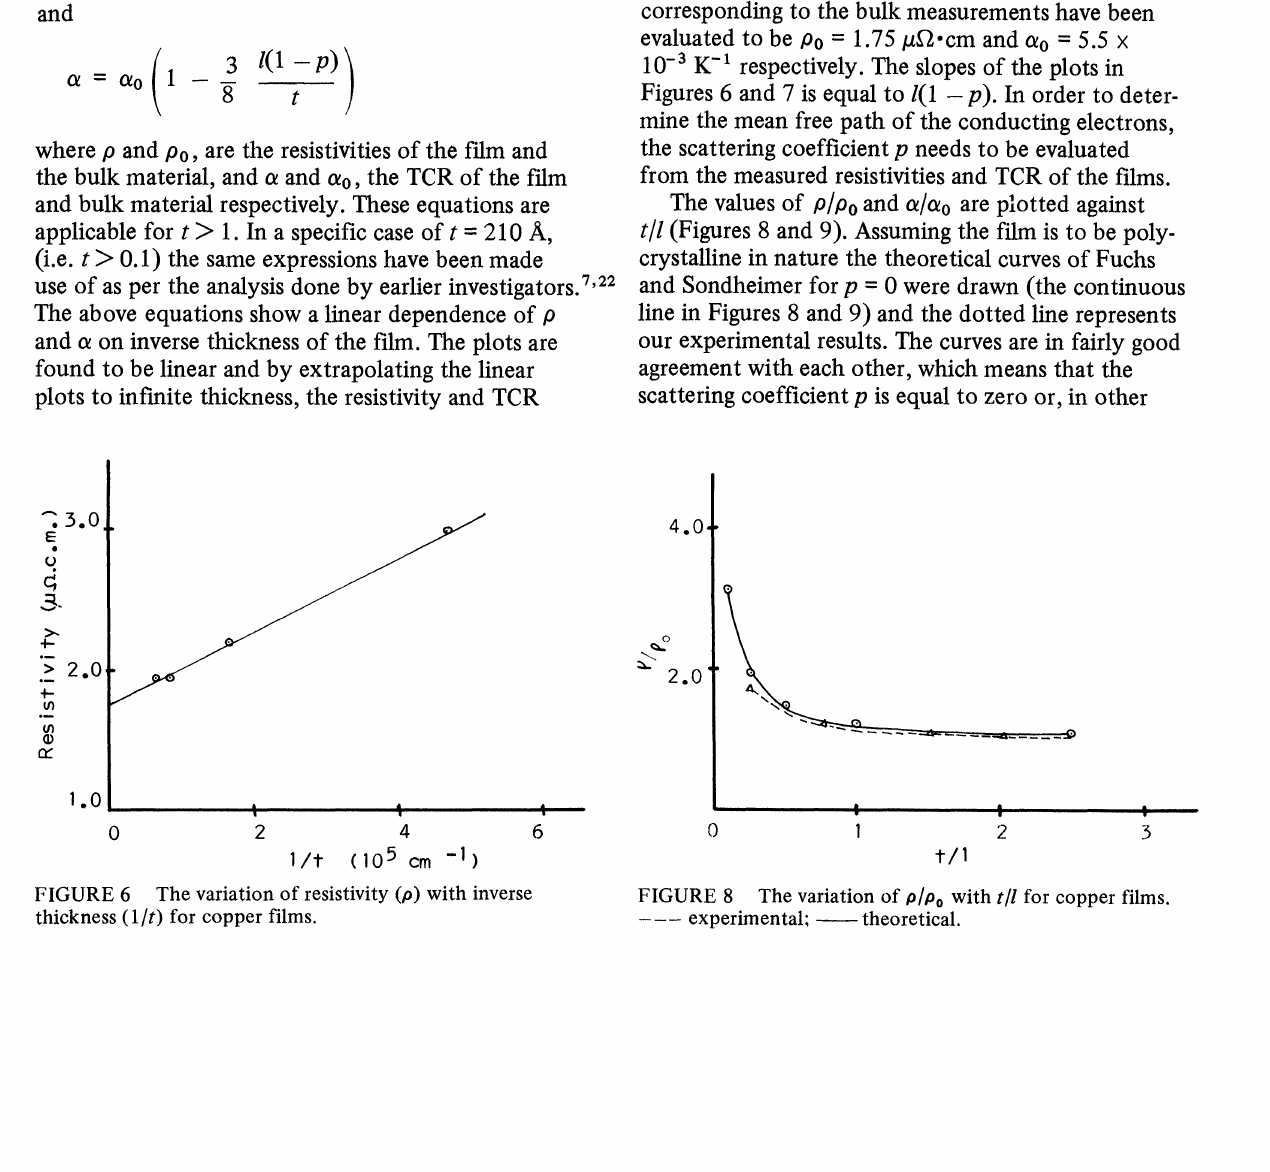
TCR () of Copper films as a function of inverse thickness (l/t).